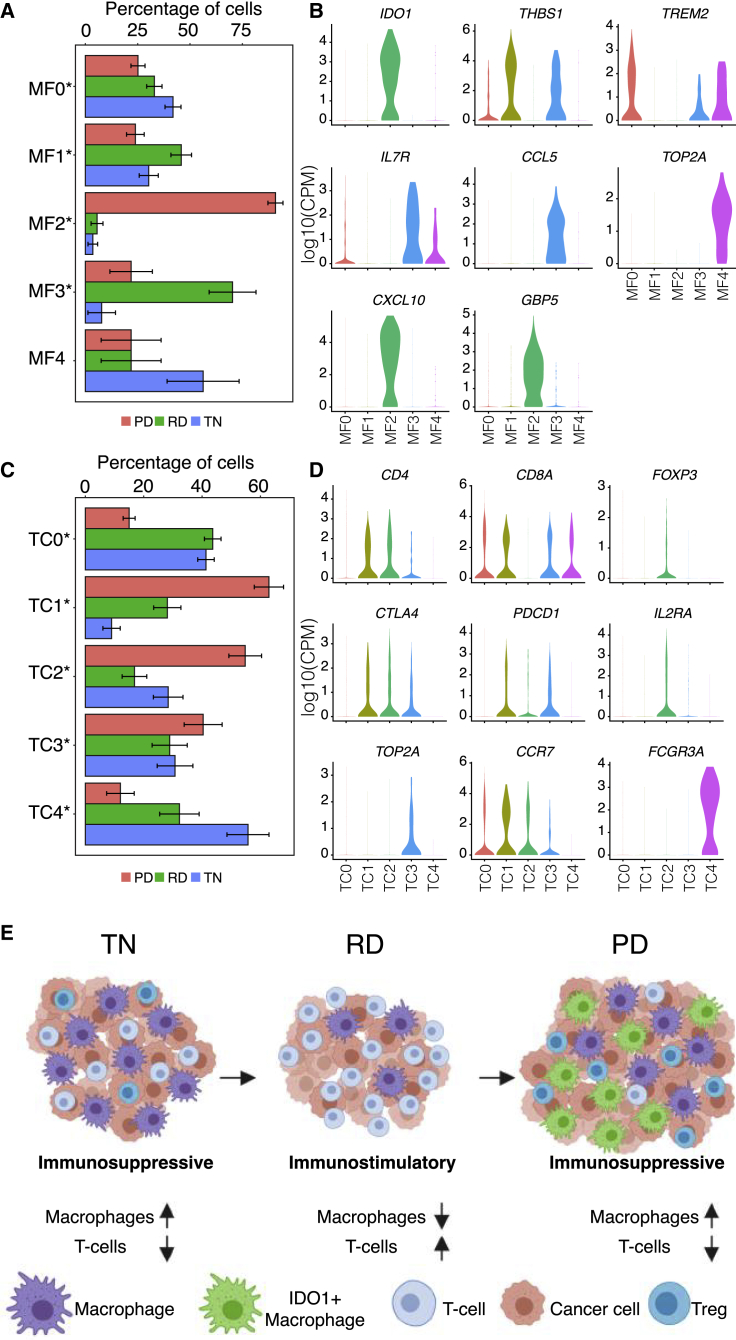
Immune Cell Subpopulations Demonstrate Unique Transcriptional Profiles within Each Treatment Time Point(A) Fraction of cells belonging to each treatment stage for each macrophage cluster in Figure S6. Error bars indicate the 95% confidence interval for the calculated relative frequencies. ∗p < 0.01 using chi-square test of independence.(B) Violin plots showing the expression level distribution of notable individual genes.(C) Fraction of cells belonging to each treatment stage for each T cell cluster in Figure S6. Error bars indicate the 95% confidence interval for the calculated relative frequencies. ∗p < 0.01 using chi-square test of independence.(D) Violin plots showing the expression level distribution of notable individual genes.(E) Graphical summary of immune microenvironment changes across treatment time points.See also Figure S7 and Tables S4 and S5.